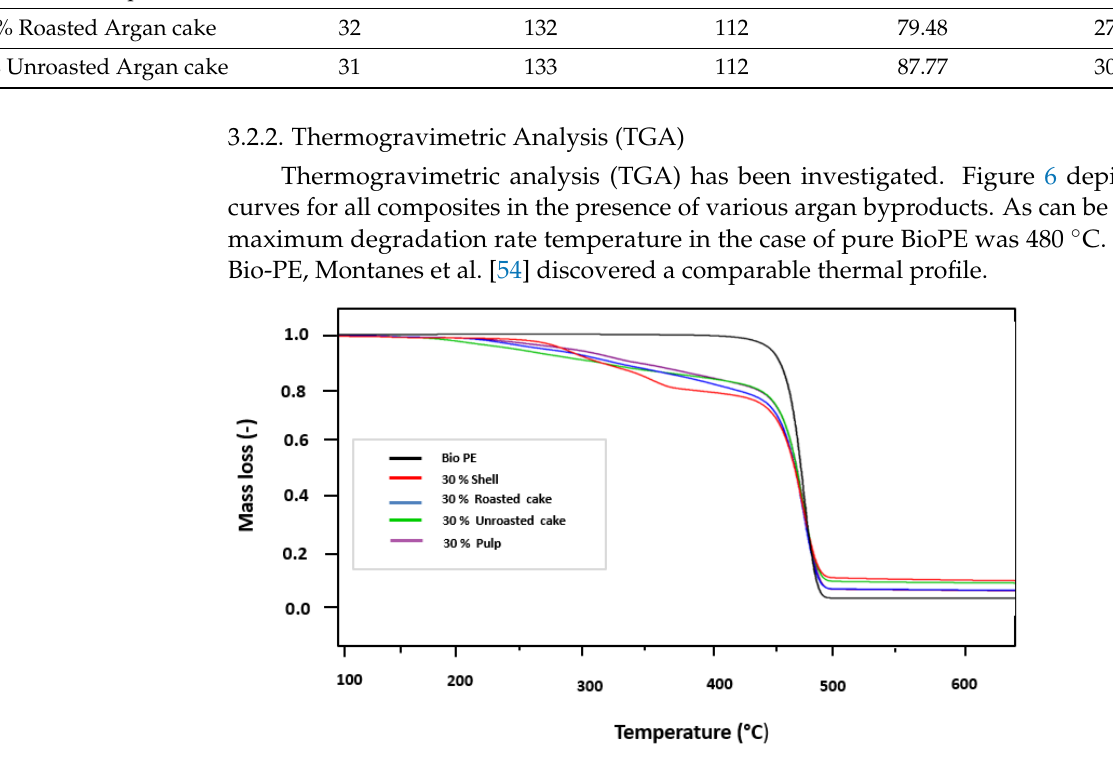
Figure 6. Thermogravimetric analysis thermogram.